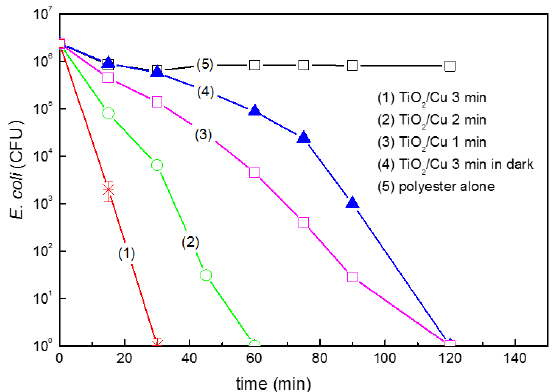
Figure 12. E. coli inactivation on TiO 2 -Cu co-sputtered for different times on polyester (PES) as indicated in the traces: (1) 3 min, (2) 2 min, (3) 1 min, (4) co-sputtered TiO 2 -Cu for 3 min in the dark and (5) PES-alone. The bacterial reduction under light irradiation used a Philips Master-18W/865 lamp (4.65 mW/cm 2 ).